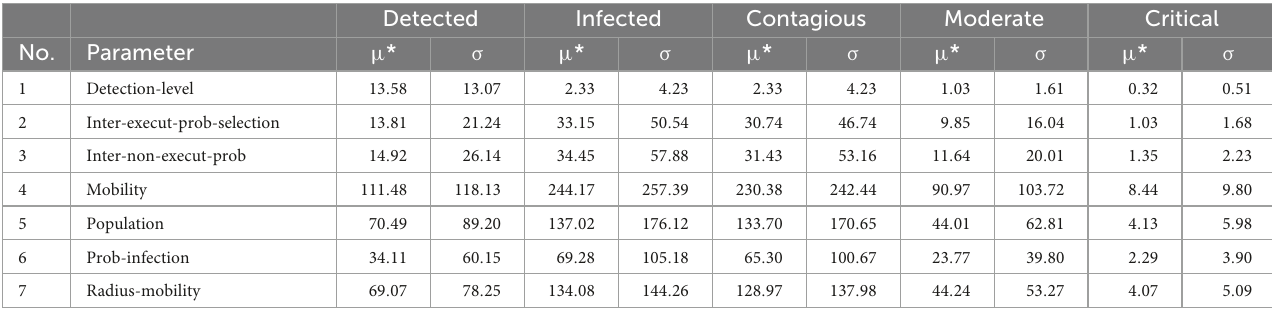
TABLE 5 Morris screening sensitivity analysis for all parameters in SAMPAN model. Detected Infected Contagious